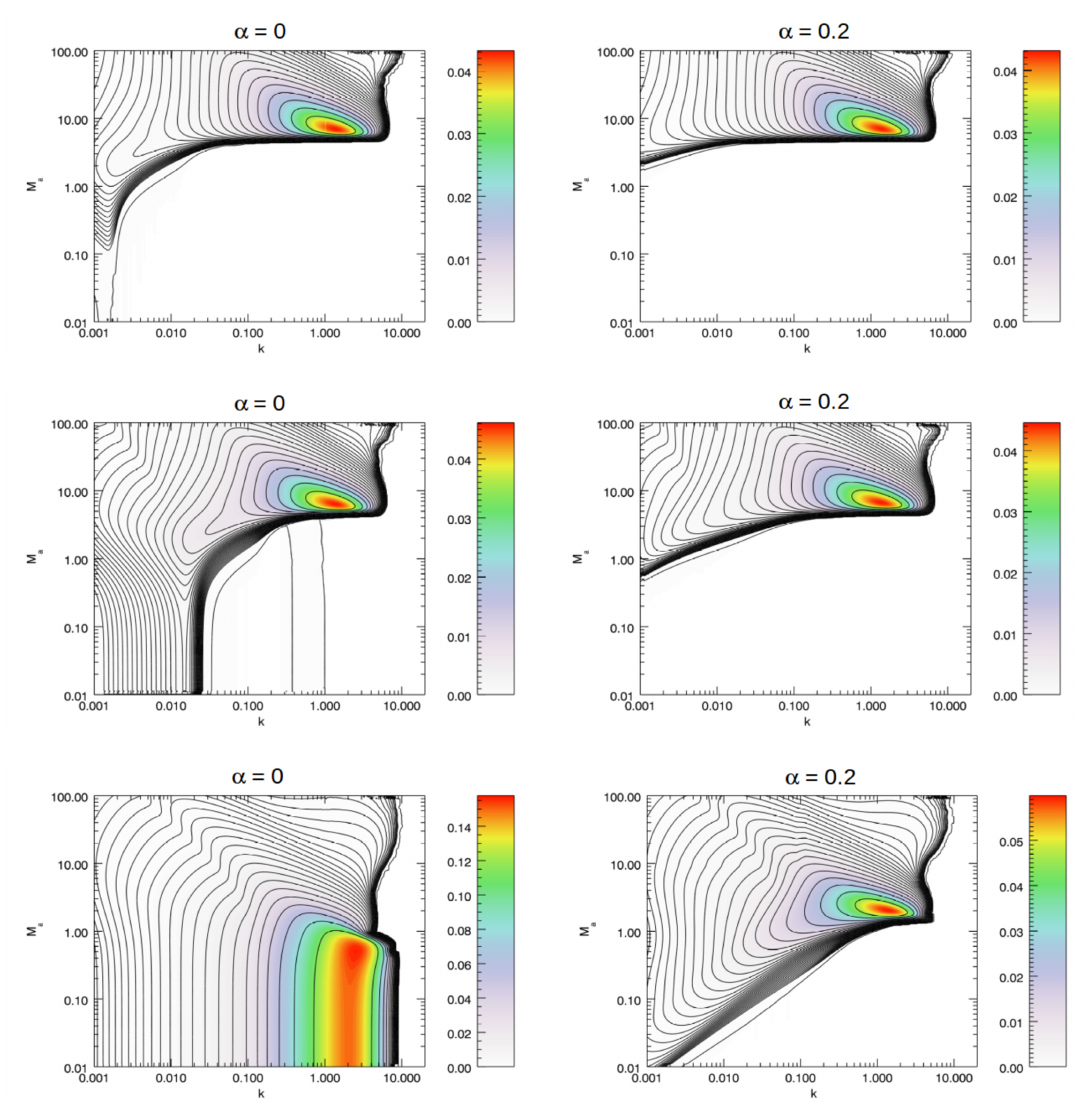
Figure 4. Growth-rate contours of instabilities in a zero pressure, magnetized, relativistic jet as a function of the wavenumber, k , and the ratio of magnetic to kinetic energies, M a , for a series of initial jet structures [94]. In all the plots, the jets have Lorentz factor 10. The left column shows models with no rotation, whereas the right column shows models with rotation (the parameter α gives a measure of rotation speed, see [94]). The upper panels give the solutions for P c = 10, i.e., with a dominating poloidal field (see the text), the middle panels give the solutions for P c = 1, and the bottom panels for P c = 0.1, i.e., dominating toroidal field. The region with M a > 1 displays the KHI solutions, and the CDI appears at low values of this parameter, i.e., for magnetically dominated jets, and mainly when the toroidal component of the field is more important (courtesy of Gianluigi